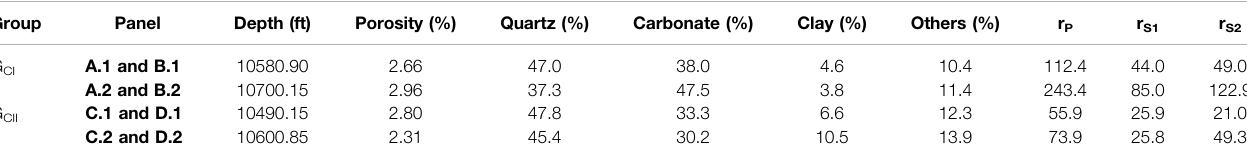
TABLE 3 | Facies C sample